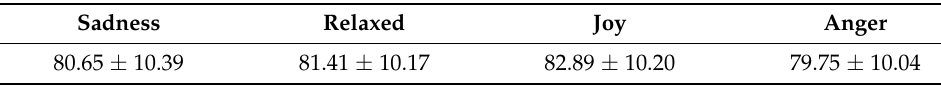
Table 6. Average and standard deviation of